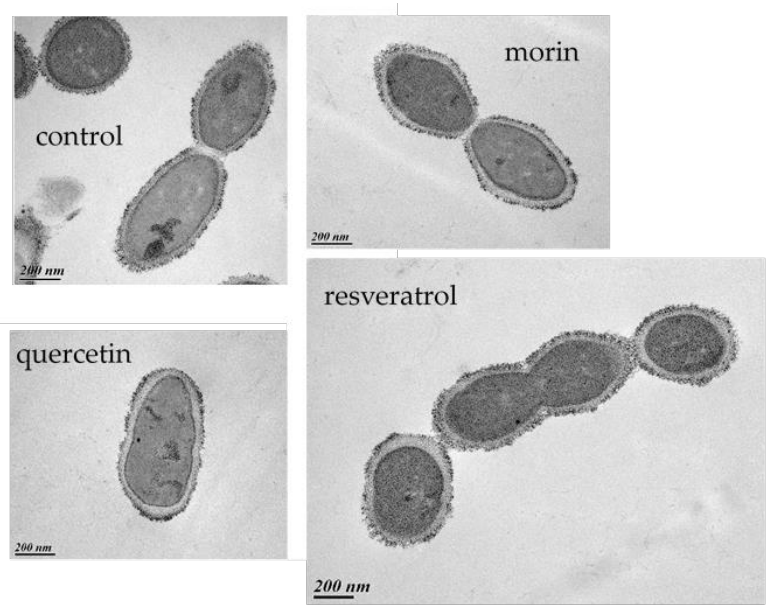
Figure 5. TEM observations of O. oeni IOEBS277 cells grown with no PCs (control), quercetin, morin or resveratrol (50 µg mL −1 ). The bars represent 200 nm.